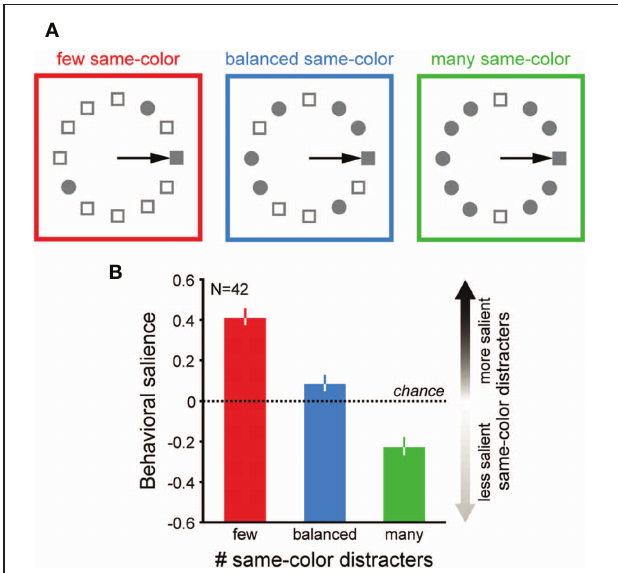
FIGURE 1 | Task and behavior. (A) The variable distracter-ratio visual search task. Displays consisted of three possible same-color/same-shape distracter-ratios: few same-color (2/9, left), balanced same-color (6/5, middle), and many same-color (9/2, right). All example displays show a correct single saccade (arrow) made to the target. (B) Average index of behavioral salience (observed errors to same-color distracters—errors expected by chance) for three monkeys performing the variable distracter-ratio task. Red: few same-color; blue: balanced; green: many. All values are mean ±